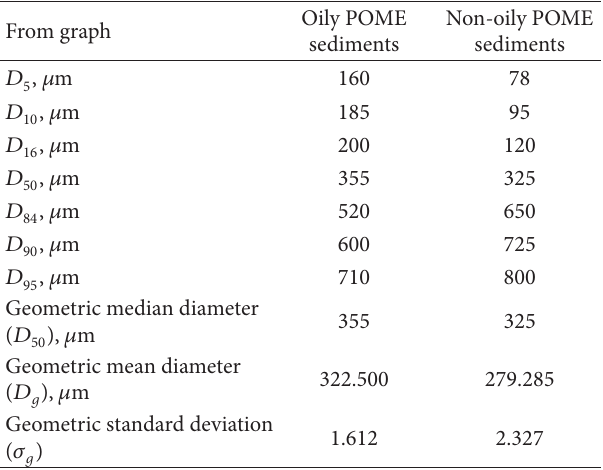
T 4: e size characteristic and statistical parameters extracted from PSD graphs of oily and non-oily POME